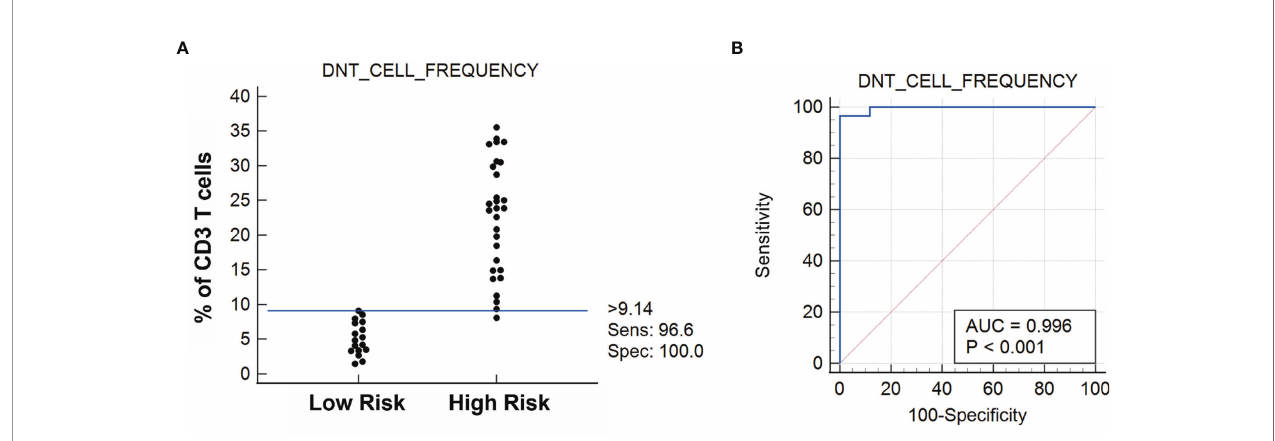
FIGURE 4 | (A) Dot diagram shows the DN T-cell frequency vs. the risk for cancer as established by the receiver operating characteristic (ROC) curve analysis showing the sensitivity and speci fi city of the test (n = 46) (B) . Statistically, >9.14% DN T cells of total T cells determine the risk for cancer, with all cases under Low Risk being benign lesions and all cases under High Risk being cancerous lesions. Please note that 1 case under High Risk (the only medullary thyroid carcinoma case in the cohort study) falls below the 9.14% cutoff